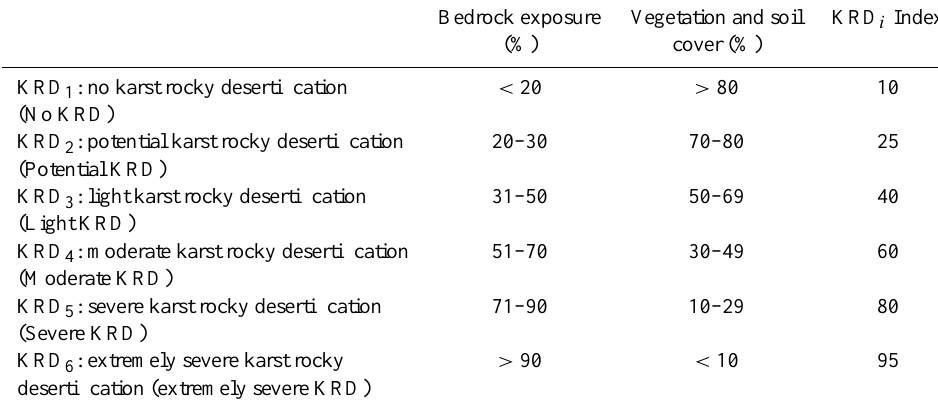
Bedrock exposure Vegetation and